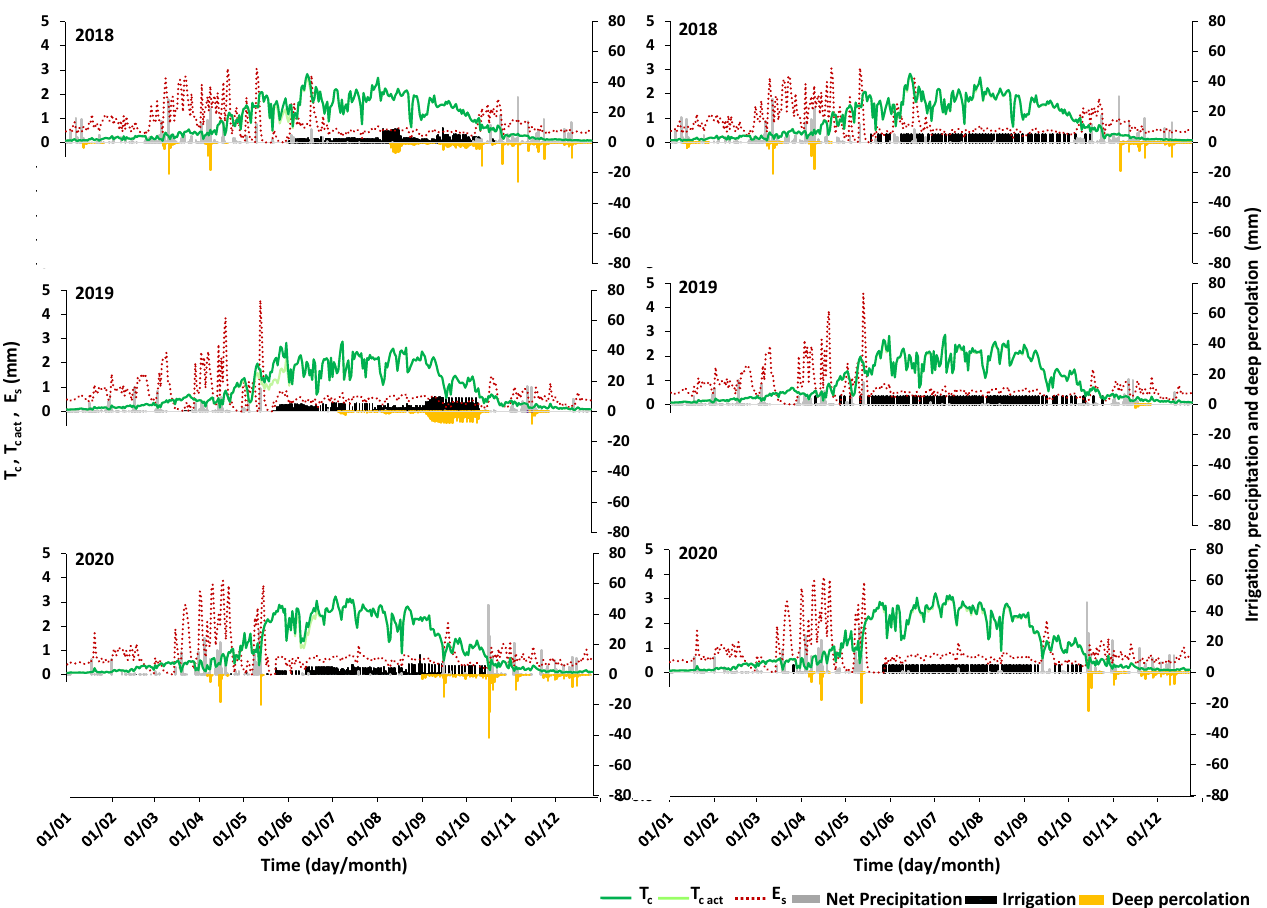
Figure 8. Daily evolution of the potential crop transpiration (T c ), actual crop transpiration (T c act ), soil evaporation (E s ), and deep percolation rates at Samora Correia vineyard as monitored in the field (left) and after optimization of the irrigation schedules (right) during 2018–2020.